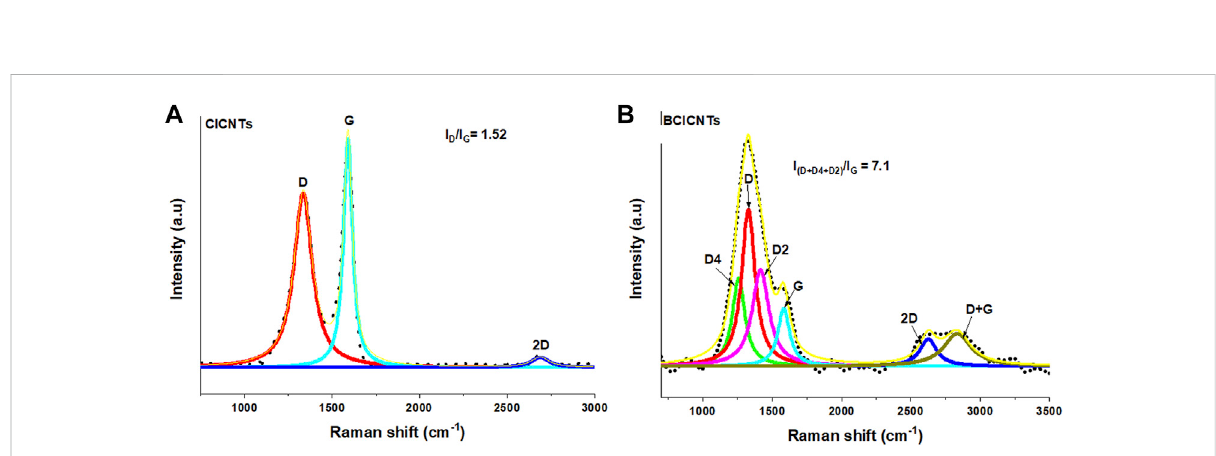
FIGURE 4 Raman spectra analysis of chlorinated (A) and boron-doped chlorinated (B) carbon nanotubes using dichlorobenzene and triphenylborane as chlorine and boron sources, respectively.